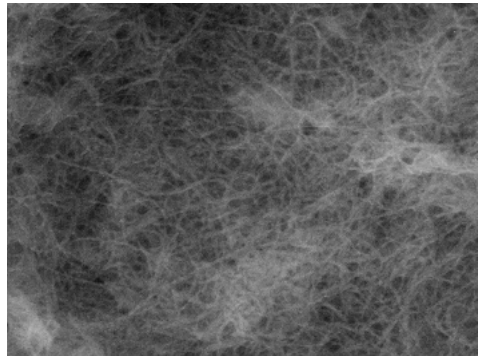
•[Au(mnt) ]. [Reproduced with permission from 2 2